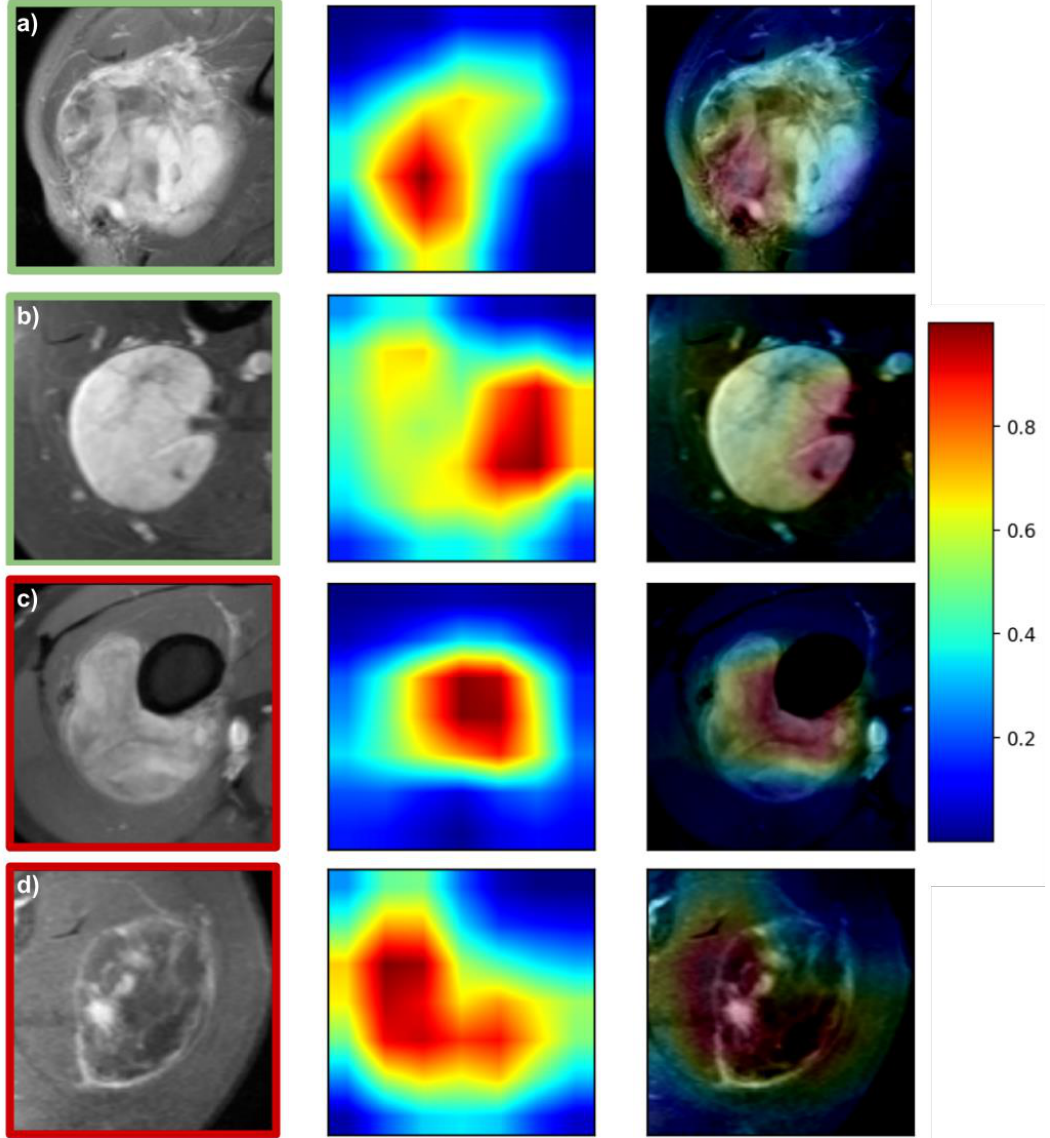
Figure 4. Attention maps of the DL-T1FSGd model. Green and red squares around images denote correct and false predictions, respectively: ( a ) correct prediction with 87% probability: high-grade (G2) synovial sarcoma—focus on tumor texture and tumor-tissue border with low confinement; ( b ) correct prediction with 95% probability: low-grade (G1) myxoid liposarcoma—focus on tumor-vessel interface with good confinement. ( c ) False prediction with 87% probability: low-grade (G1) myxoid liposarcoma—focus on tumor-bone interface. ( d ) False prediction with 98% probability: high-grade (G3) pleomorphic sarcoma—focus on central tumor parts and tumor-tissue border, low in-plane